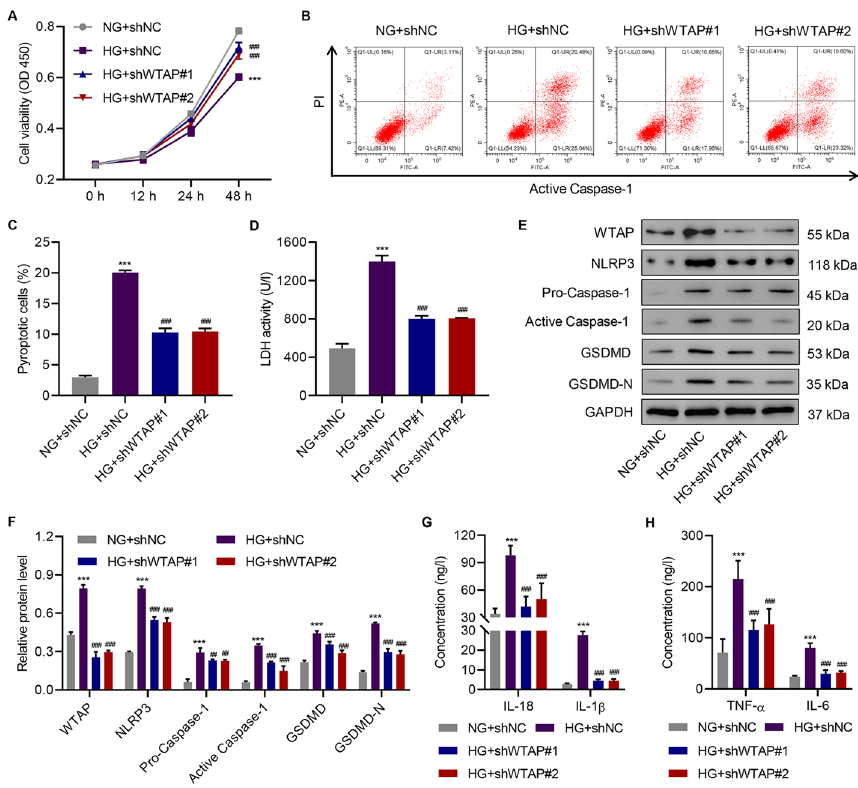
Fig. 2 Knockdown of WTAP inhibits high glucose (HG)-induced cell pyroptosis and pro-inflammatory factor release in HK-2 cells. A Cell viability; ( B , C ) cell pyroptosis; ( D ) LDH activity; E , F expression of WTAP, NLRP3, pro-caspase-1, active caspase-1, GSDMD, and GSDMD-N; and ( G , H ) the release of IL-18, IL-1β, TNF-α, and IL-6 in HK-2 cells treated with NG or HG with or without WTAP knockdown ( n 3). One-way analysis of = variance was used to analyze the data among multiple groups, followed by Tukey’s post hoc test. *** P < 0.001 compared with NG shNC. ## P < 0.01, ### P < 0.001 compared with HG + +